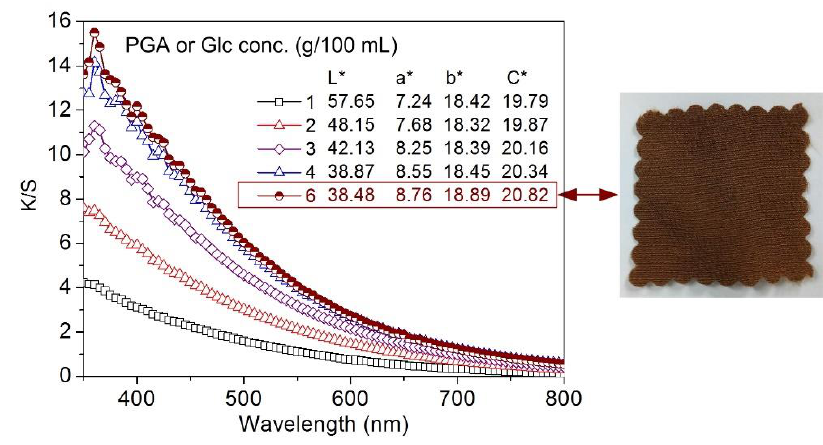
Figure 5. Spectral data of silk fabrics dyed with the PGA/Glc reaction products at various concentrations (The inserted photo represents the dyed silk sample).